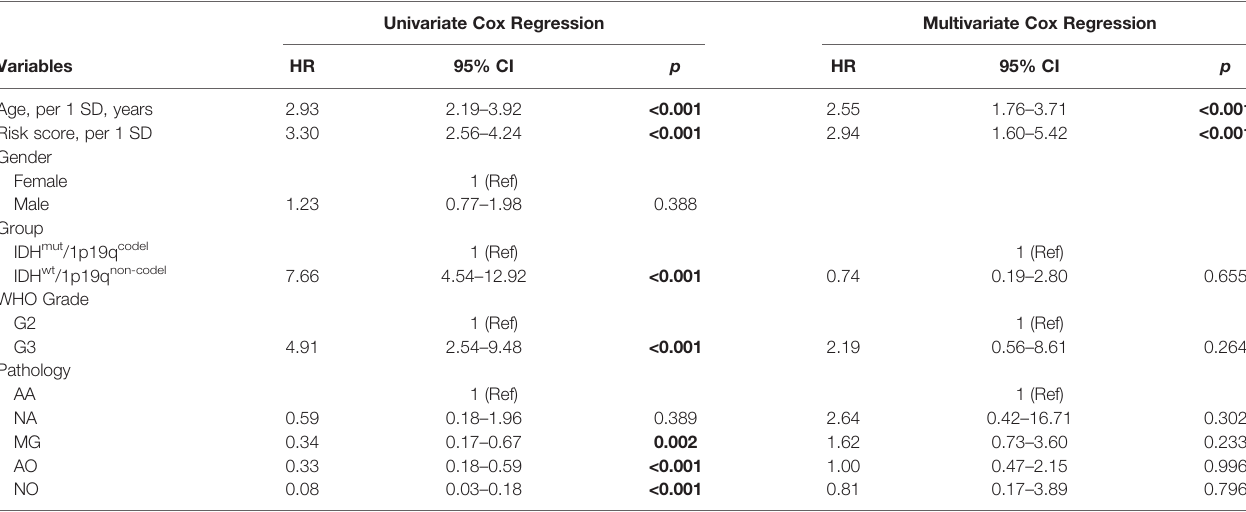
TABLE 1 | Univariate and multivariate Cox regression of variables.